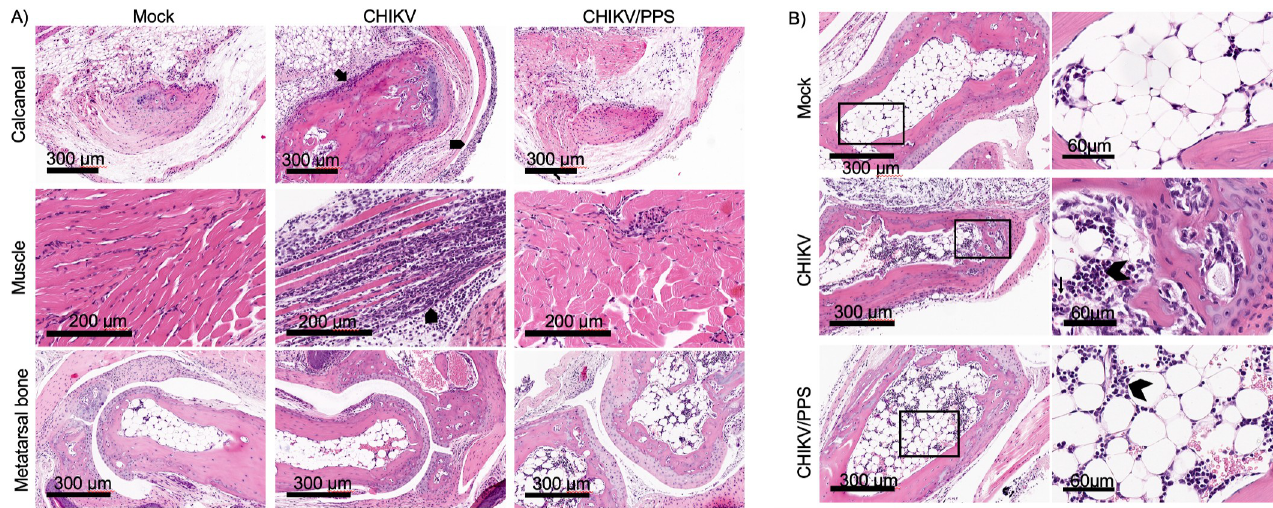
Fig 2. Histological analysis of PPS-treated mice at peak disease. C57BL/6 mice were infected s.c. with 10 4 PFU CHIKV or PBS alone and received daily injections of PPS-treatment or mock with PBS. Mice were sacrificed at 7 d.p.i. and tissues collected and fixed for histological analysis. (A) H&E staining of the hind limbs of CHIKV-infected mice. Increase in cellular infiltrates were seen in the calcaneal region, the muscle, and the tissue adjacent to the metatarsal bones in CHIKV-infected untreated mice. CHIKV-infected PPS-treated mice showed a reduction in inflammatory cells when compared to CHIKV-infected untreated mice. Scale bars represent 200 μ m (muscle) and 300 μ m (calcaneal and bone). (B) Infiltrating cells can also be found in the bone marrow. Again, CHIKV-infected PPS-treated mice showed a reduction in infiltrates when compared to CHIKV-infected untreated mice. Scale bars represent 60 μ m and 300 μ m. All slides were scanned with the Aperio Scan Scope XT digital slide scanner. Images are representative of 5 mice per group, 2 sections per mouse. Mock-infected; mock, CHIKV- infected mock-treated; CHIKV, CHIKV-infected, PPS-treated; CHIKV/PPS.